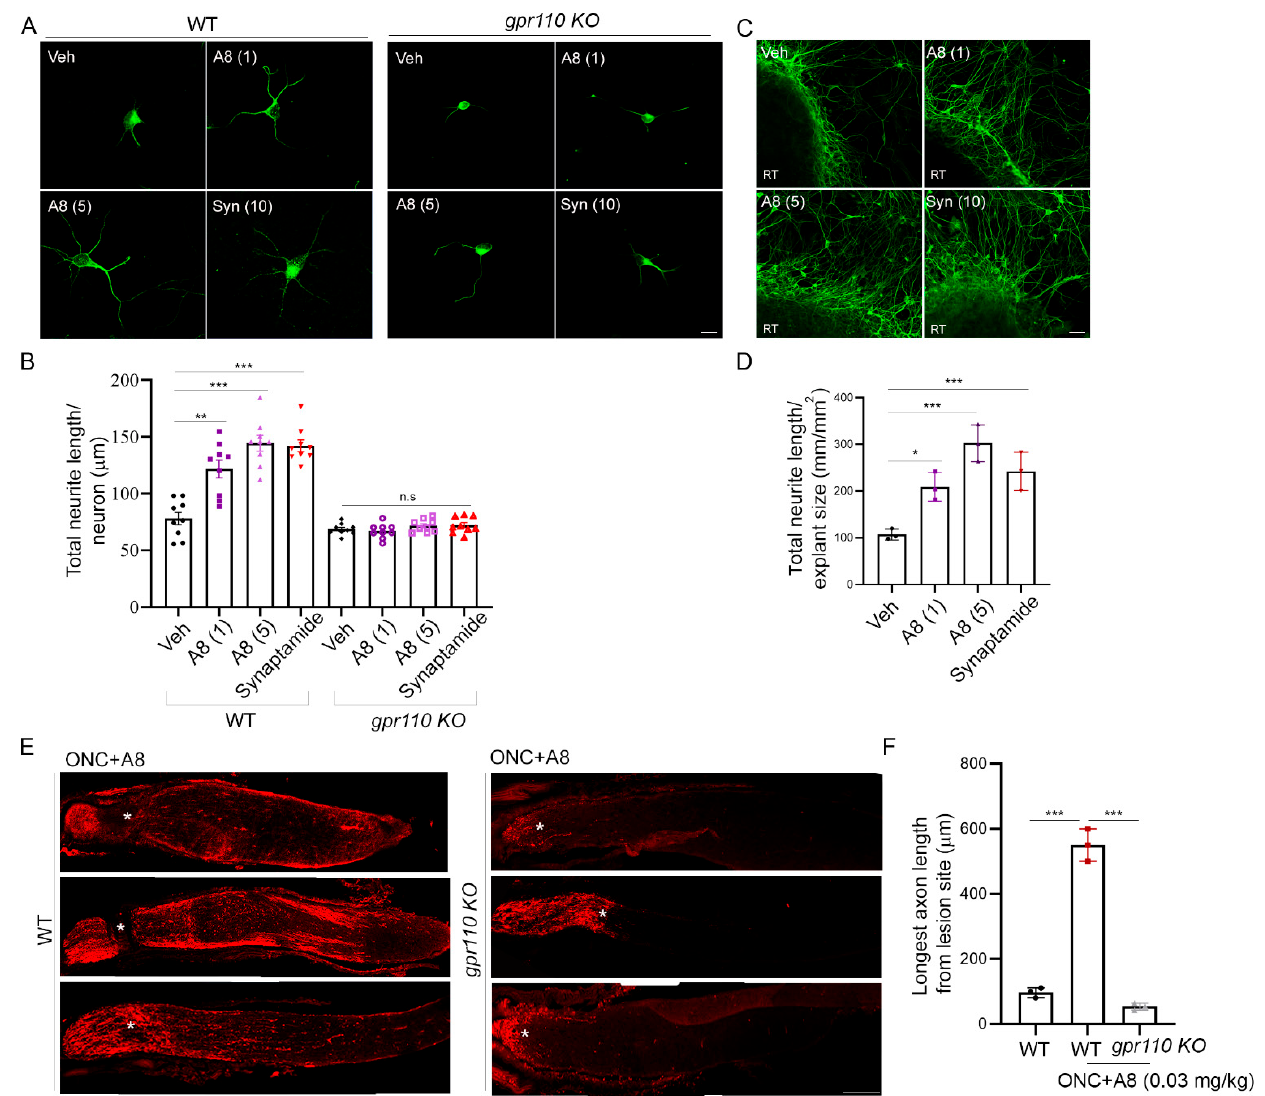
Figure 7. A8, a FAAH-resistant structural analogue of synaptamide, improved neurite outgrowth and axon growth after injury. ( A , B ) Improved neurite outgrowth by A8 in cultured cortical neurons from WT but not from gpr110 KO mice, indicating the GPR110-dependent nature of A8 bioactivity. Neurite length was evaluated after treating DIV0 cultures with synaptamide (10 nM) or A8 (1 or 5 nM) for 3 days. ( C , D ) RGC neurite growth in retinal explant cultures promoted by synaptamide or A8 as indicated by the quantification of axon length after immunostaining with anti β -III tubulin antibody. ( E , F ) GPR110-dependent stimulatory effect of intravitreal injection of A8 at 0.03 mg/kg on axon extension, shown by the micrographic images of CTB-labeled axons ( E ) and quantitative data showing the longest axon length ( F ) obtained at 4 weeks after ONC. Some of the optic nerve micrographs ( E ) were obtained after the manual stitching of image sections using Photoshop. Data are expressed as mean ± s.e.m with n = 9 ( A ) and n = 3 ( D , F ) per group. RT, retinal tissue; * p < 0.05, ** p < 0.01, *** p < 0.001; Scale bars, 10 µm ( A ), 50 µm ( C ) and 100 µm ( E ).